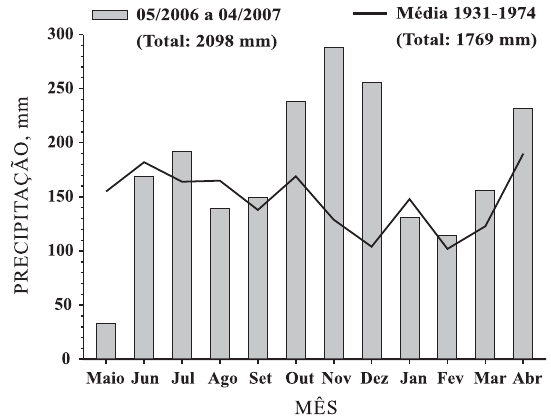
Figura 6. Índices pluviométricos históricos (IPAGRO, 1989) e observados durante a realização do experimento em Santa Rosa,